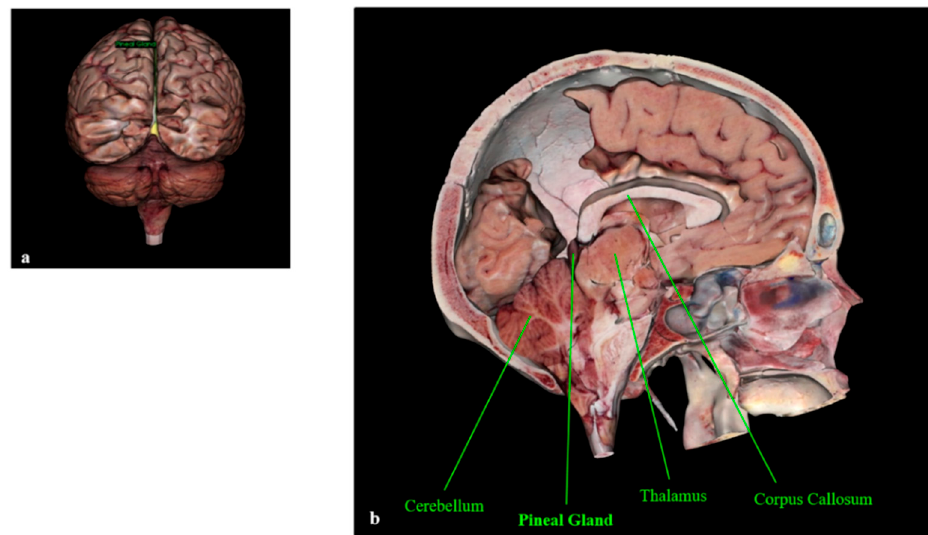
Figure 1. Human pineal gland ( a ) and its anatomic boundaries ( b ). The pineal gland is visible in yellow ( a ). Anatomage Inc.—Anatomage Table EDU. The 3D rendering of the cadaver data is from Anatomage Table.